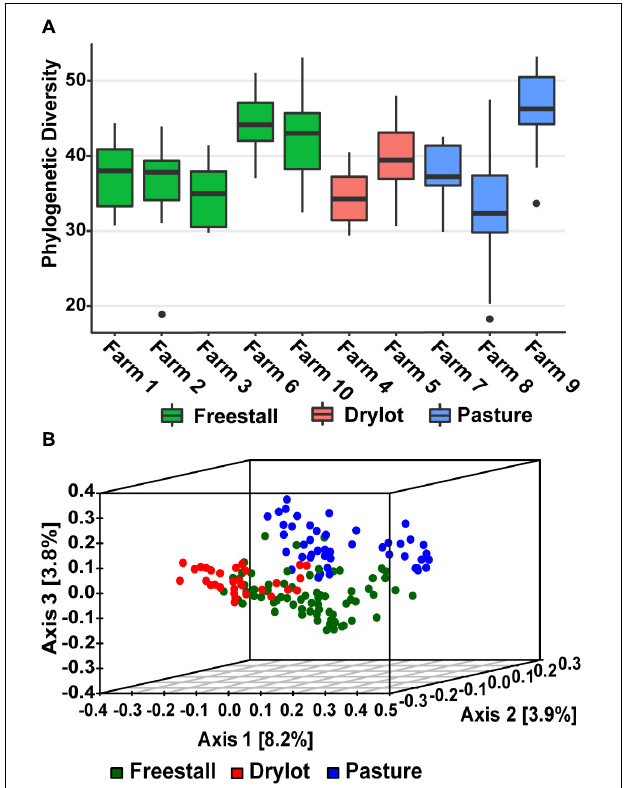
FIGURE 1 | Alpha and beta diversity of samples. (A) Average Phylogenetic Diversity (PD) across farms was determined by averaging the sum of all branch lengths of the OTUs present in each fecal sample (Faith’s PD). Alpha diversity of fecal bacterial communities was not significantly affected by housing type, but farm did significantly ( p = 4.9 × 10 − 10 ) affect alpha diversity. (B) Beta diversity of samples graphed as PCoA of unweighted UniFrac distances colored by housing type. Pasture farms cluster way from the other housing types and are more similar to freestall then dry lot